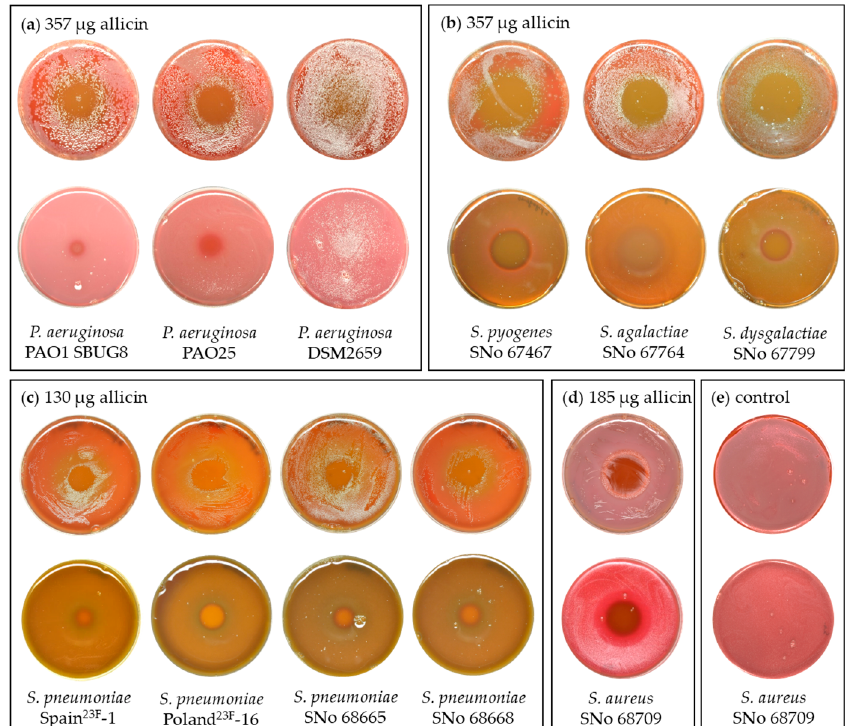
Figure 2. Antibacterial activity of allicin vapor. The Petri dish base with bacteria either spread on the agar surface (upper rows), or with bacteria-seeded agar (lower rows) were inverted over a 20 µ L droplet of allicin solution in the center of a 9-cm diameter Petri dish lid. The absolute amount of allicin ( µ g) in the 20 µ L droplet is stated. ( a ) The antimicrobial effect of allicin vapor on P. aeruginosa PAO1 SBUG8, PAO25, and the highly resistant DSM2659 strain, respectively; ( b ) The antimicrobial effect of allicin vapor on Streptococcus pyogenes , S. agalactiae , and S. dysgalactiae equisilimlis ; respectively ( c ) The antimicrobial activity of allicin vapor on Streptococcus pneumoniae multi-drug resistant (MDR)-strains Spain 23F -1 and Poland 23F - and SNo 68665 and SNo 68668 and 16; ( d ) The antimicrobial effect of allicin vapor on Staphylococcus aureus ; ( e ) example control plates placed over water droplets without allicin showed uniform bacterial growth.